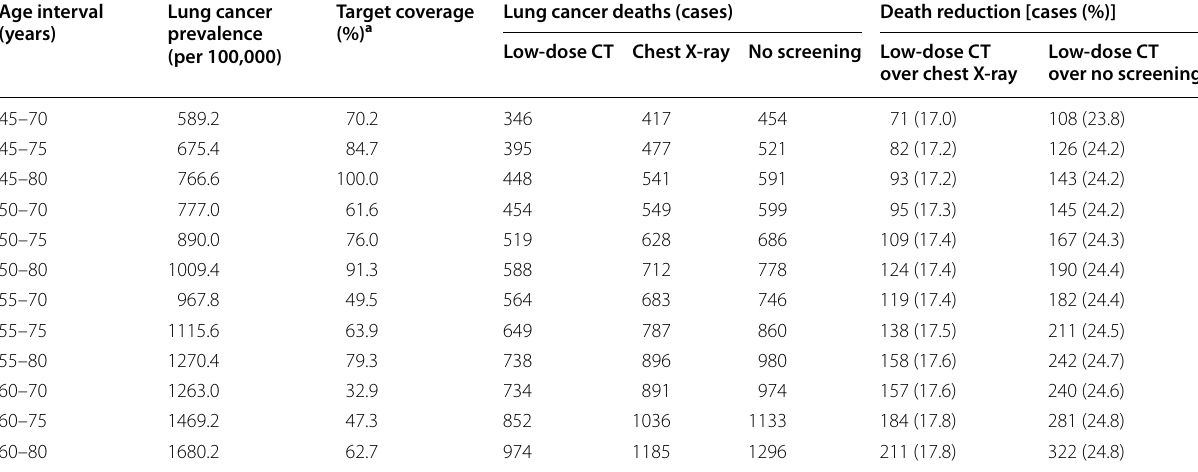
a Proportion of lung cancer patients within the listed age interval among all lung cancer patients aged 45–80 years in urban China